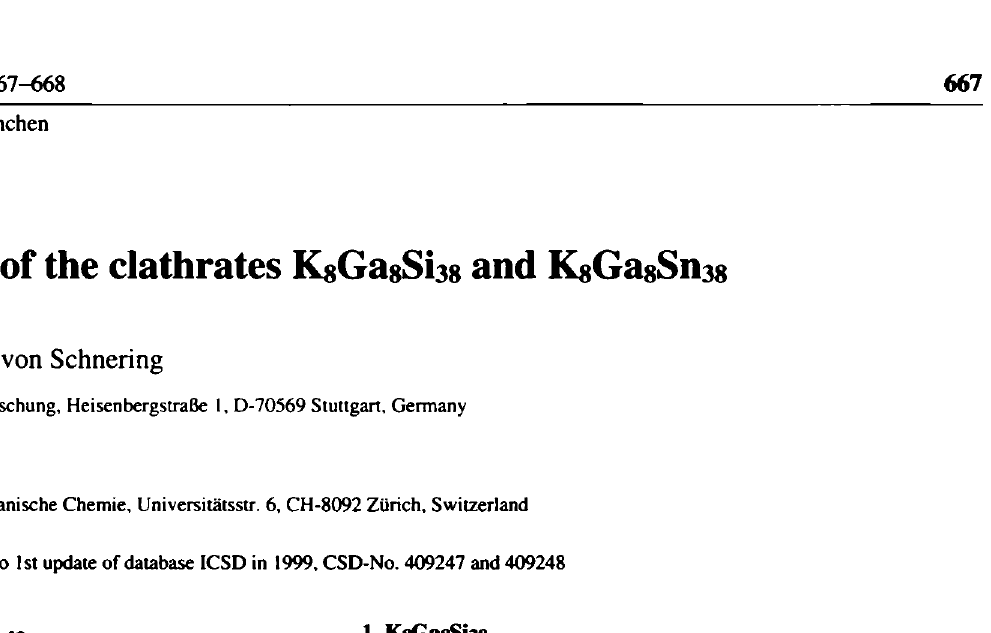
LK8Ga8SÎ38 Source of material: Stoichiometric mixtures of the elements were sealed in Nb/Ta capsules under Ar, heated up to 1270 К (3 h), annealed at 970 К (2-3 d) and cooled down. The grey brittle compound is a semiconductor, stable in air and against dilute acids and bases (see ref. 1). Reactions with different Ga:Si ratios gave no indications for a homogeneity range (powder patton) in contrast to ref. 2. The refmement of the site occupancies results in the composition (figure): dl = 2.367(1) Kdl = 2.404(1) Â, d3 = 2.464(1) Â, d4 = 2.447(1) Â. GasKsSias, cubic, Ρηβη (No. 223), a =10.427(1) Λ, V=1133.6 Â^ Z=\,R(F) =0.020, R^F) =0.017. Table 1. Parameters used for the X-ray data collection